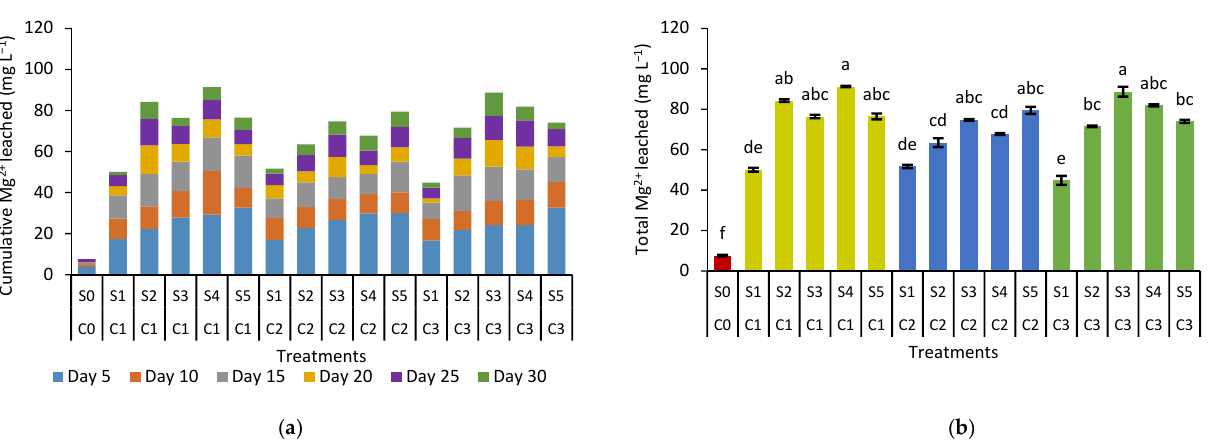
Figure 7. ( a ) Cumulative magnesium in leachates at five-day intervals and ( b ) total magnesium in leachates for the different treatments after thirty days of leaching. Different letters indicate significant mean differences using Tukey’s HSD test at p ≤ 0.05. Error bars represent the standard error of the mean.